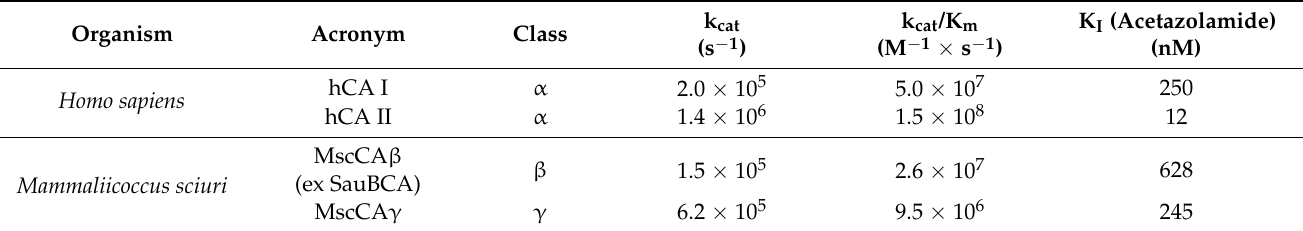
Table 1. MscCA β and MscCA γ kinetic parameters were compared with those obtained for the two human α -CA isoenzymes (hCA I and hCA II). The β and γ -class enzymes were investigated for the